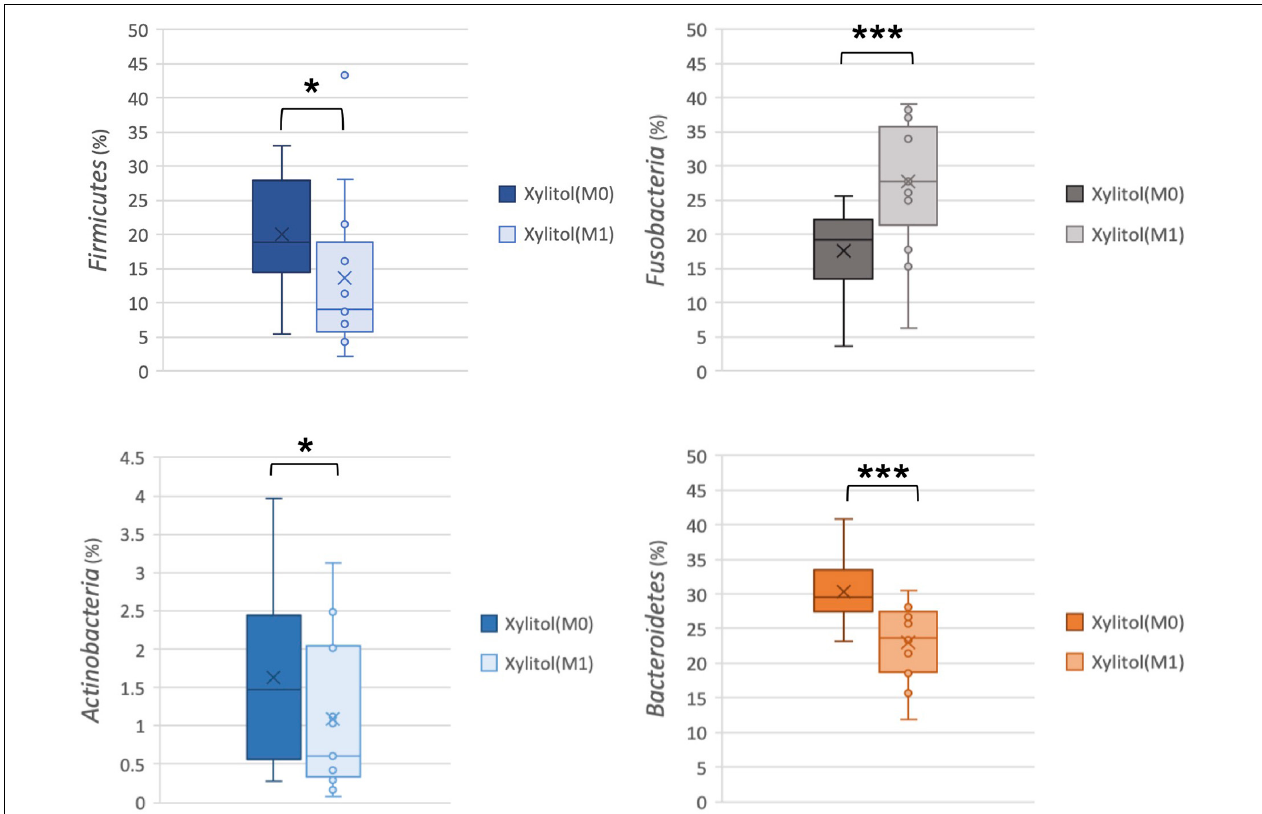
FIGURE 3 | Comparison of relative abundance at the phylum level from the xylitol gum group at M0 and M1; * p < 0.05, and *** p < 0.001 respectively, using Wilcoxon’s test.